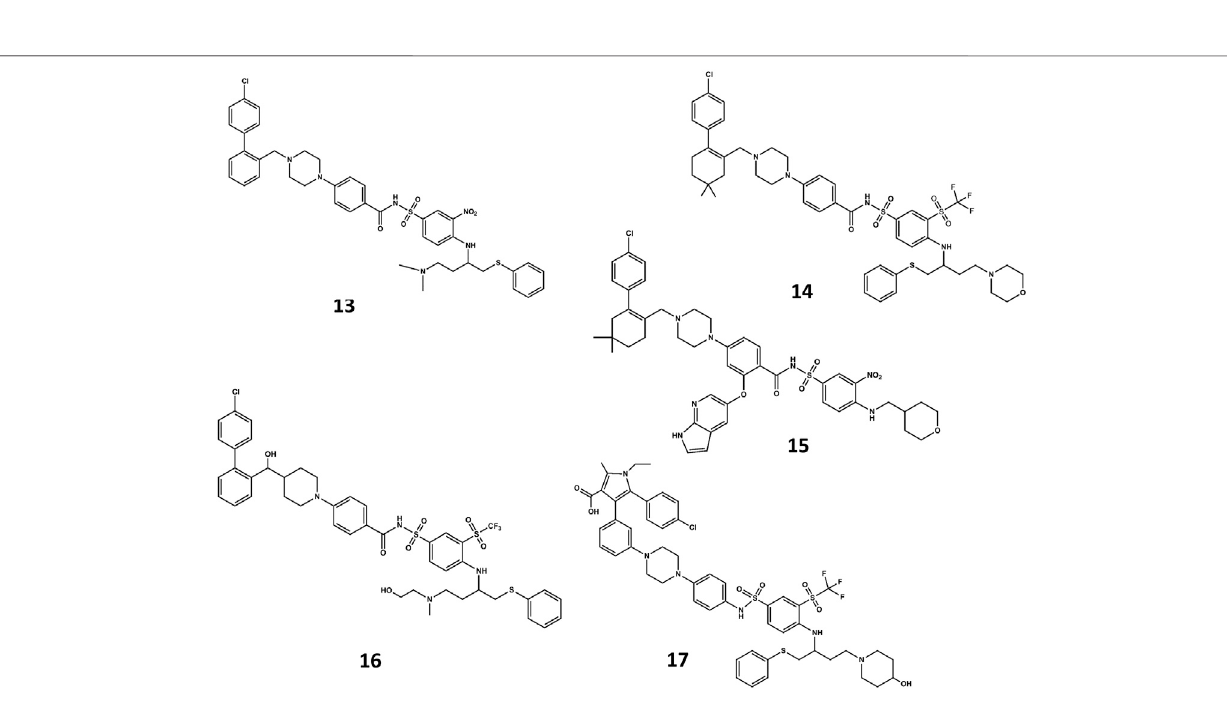
Frontiers in Molecular Biosciences |